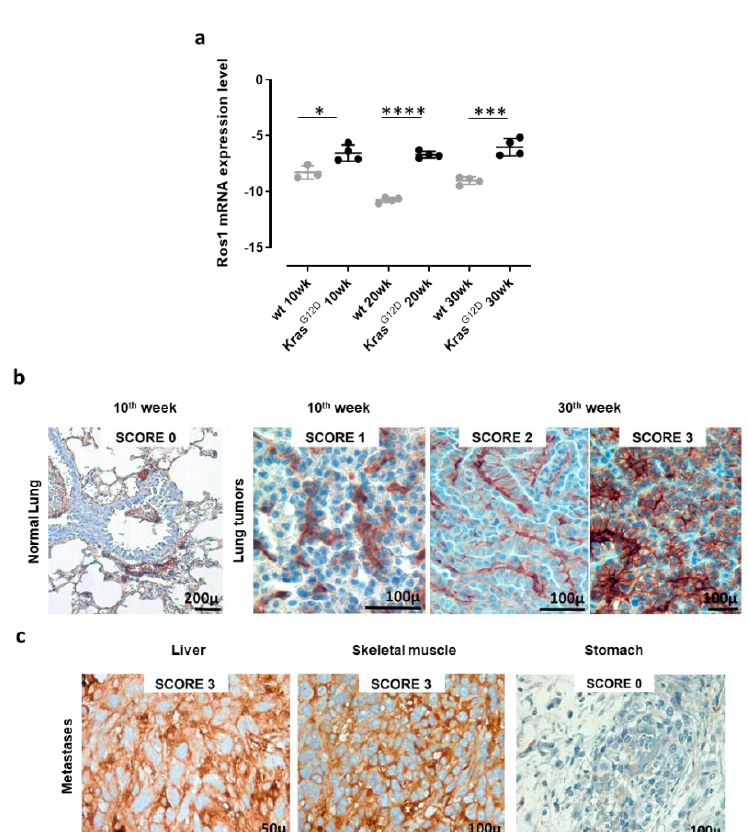
Figure 2. Receptor tyrosine kinase ROS1 expression in lung tumors and metastases from K-Ras G12D transgenic mice. ( a ) qPCR for ROS1 mRNA expression levels in lungs from 10, 20, and 30-week-old wt and K-Ras G12D mice (N = 3–4). The results are expressed as Delta C T (-Dct) between the C T value of the ROS1 gene and the C T value of the GAPDH housekeeping gene. Each dot represents the evaluation of the relative mRNA expression level in a single mouse. Statistically significant di ff erences were calculated using the Student’s t -test: * p = 0.02; *** p < 0.0006; **** p < 0.0001. ( b ) Representative images of ROS1 IHC staining of lung samples from a wt (normal lung) mouse, a 10-week-old K-Ras G12D mouse, and two di ff erent lung lesions from the same 30-week-old K-Ras G12D mouse. The ROS1 IHC score was attributed as described in the Materials and Methods section. N = 4 mice were analyzed. ( c ) Representative images of the ROS1 IHC staining of metastatic lesions found in a 48-week old K-Ras G12D mouse (liver, skeletal muscle, and stomach). N = 4 mice were